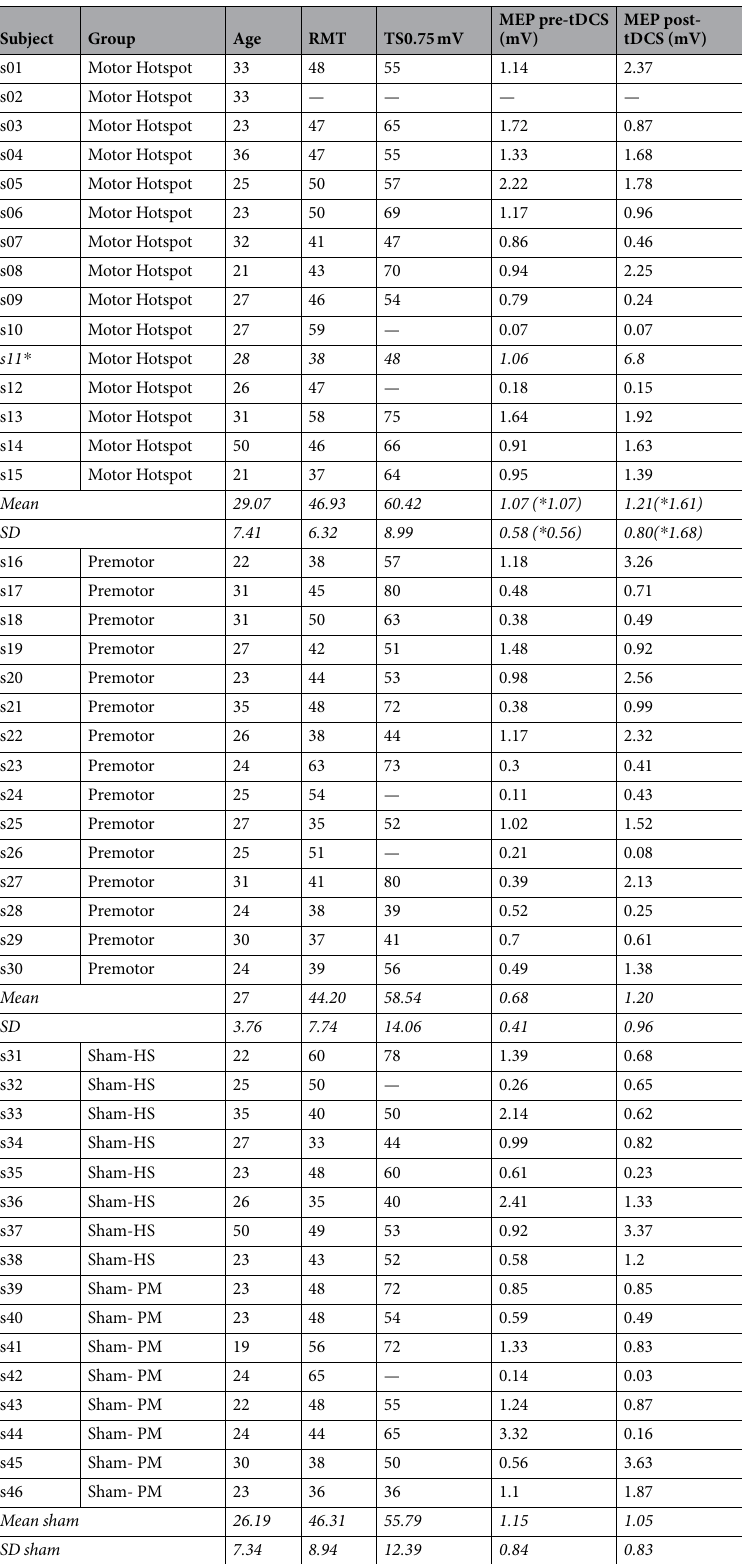
Table 1. Initial cortical excitability measurements. SD: standard deviation; RMT: resting motor threshold, * outlier, —indicates the measurement could not be elicited. For the Motor Hotspot group, MEP mean and SD are presented excluding the outlier and with the outlier ( * ). Motor Hotspot: HD-tDCS applied over the left TMS- defined motor hotspot, Premotor: HD-tDCS applied over the left premotor cortex, Sham-HS: Sham group with electrodes over the left motor hotspot, Sham- PM: Sham group with electrodes over the left premotor